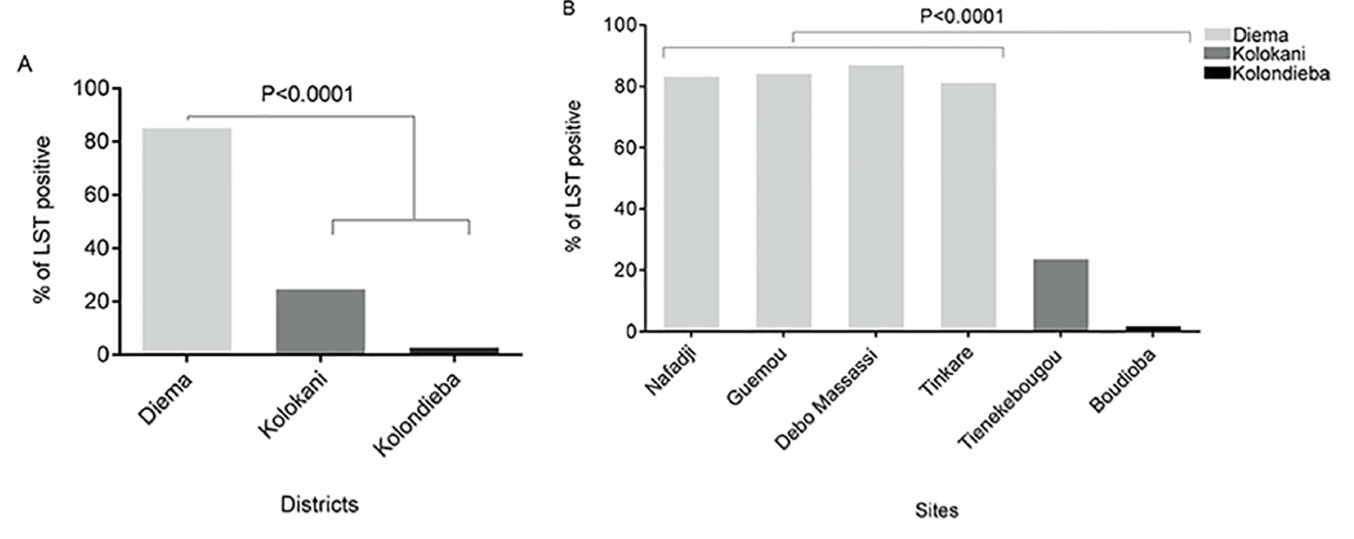
Fig 2. Prevalence of LST positivity by district (A) and by site